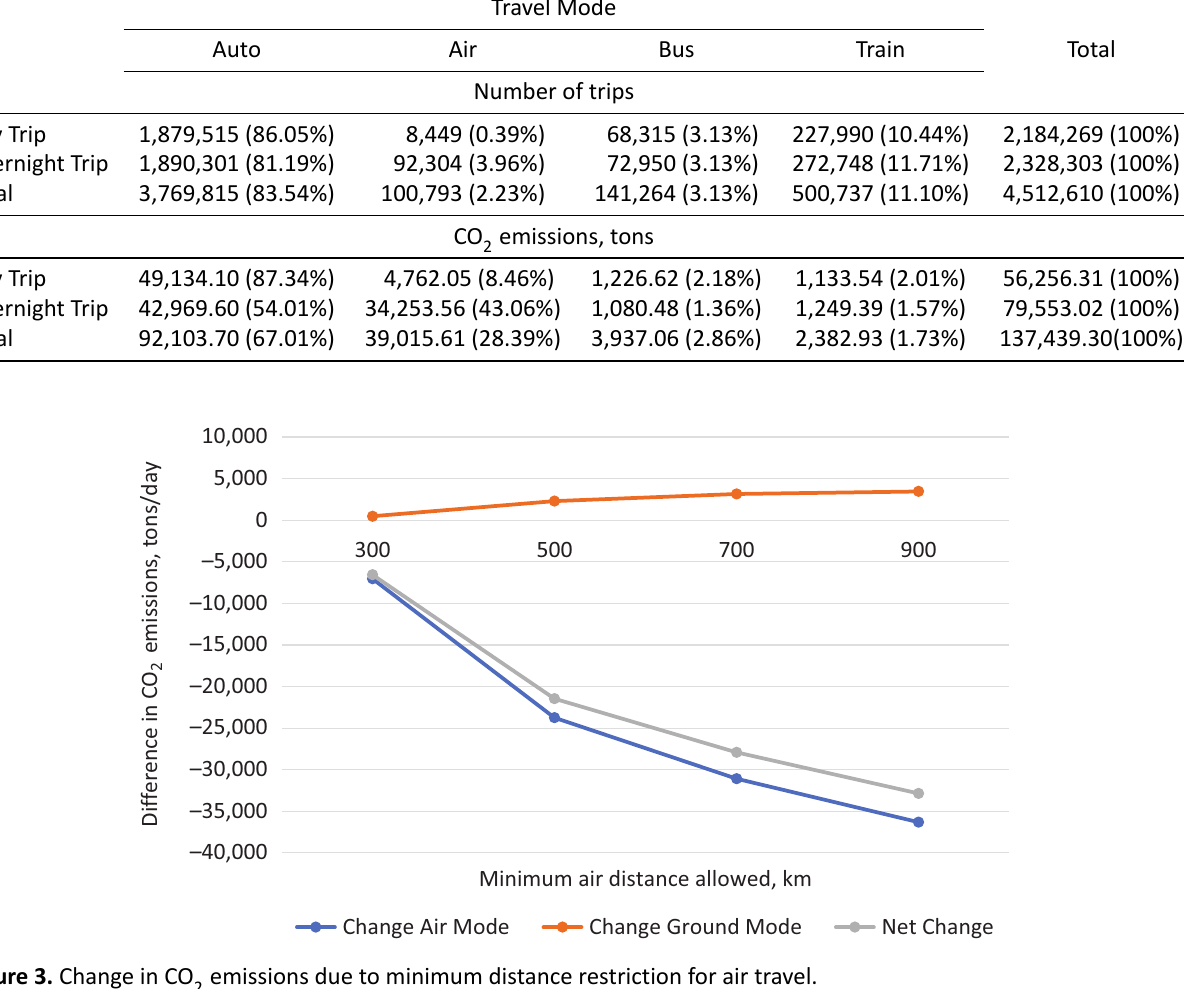
emissions by mode. 2